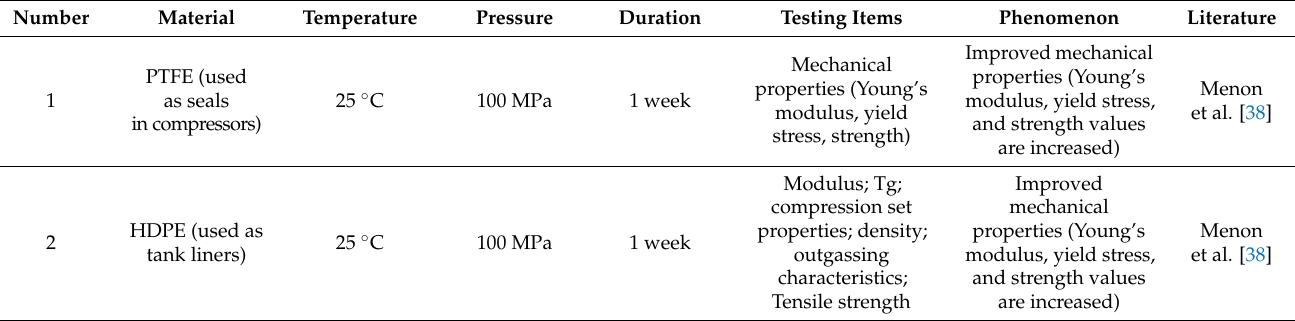
Table 5. Investigations on ageing behaviors of thermoplastics in a compressed hydrogen